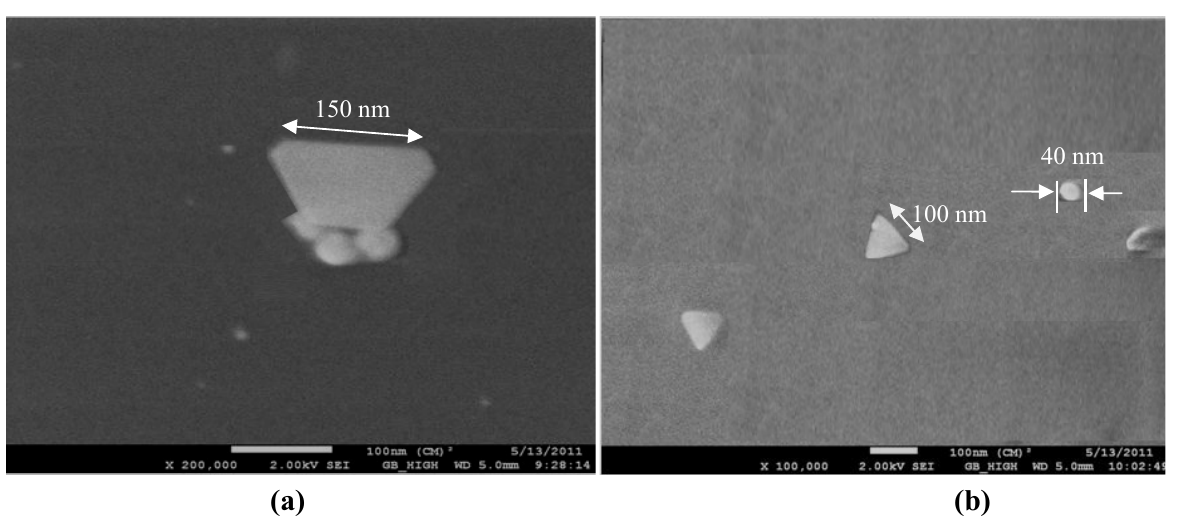
Figure 4. SEM images of samples UV-irradiated for 90 min and annealed for 30 min at 70 °C (a) and 90 °C (b) ,